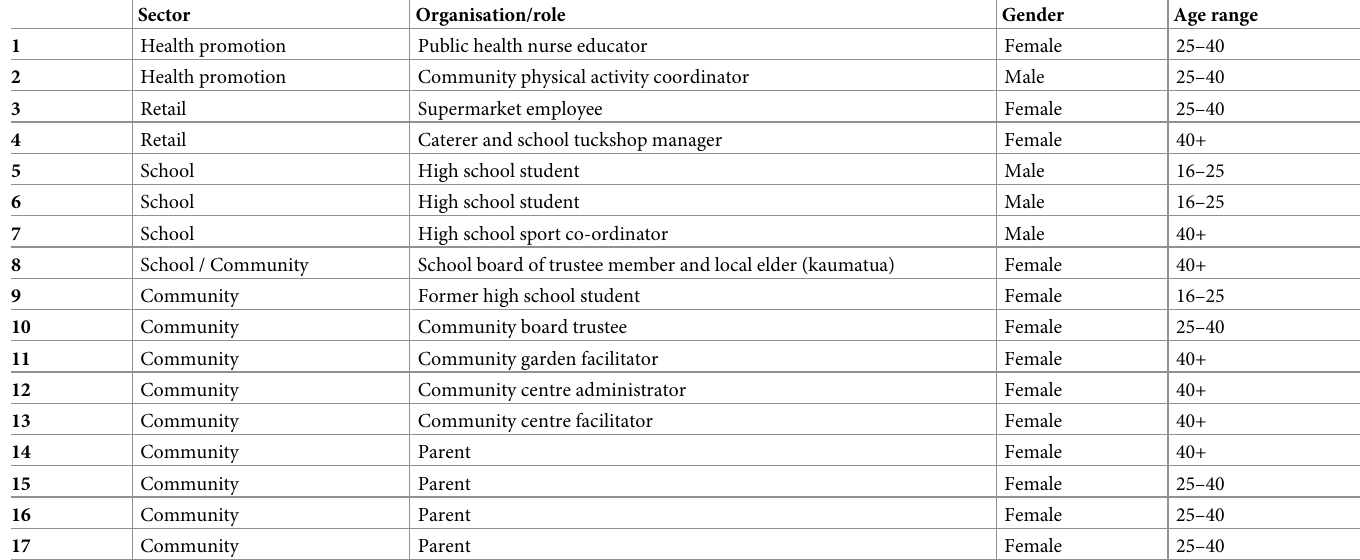
Table 2. Description of the workshop